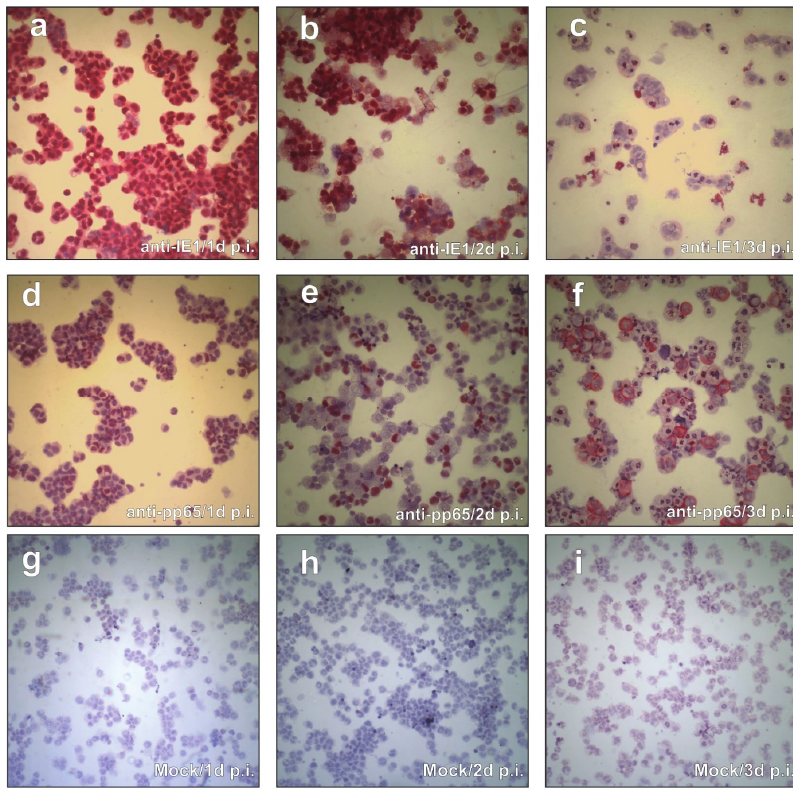
Figure 1. Viral protein expression in CAP sus. ( a – f ), cytospin preparations of HCMV infected CAP sus. , stained with mAbs against IE1 ( a – c ) and pp65 ( d – f ). Cells were infected with TowneUL130rep at an m.o.i. of 0.5. ( g – i ), mock-infected cells. Cytospin preparation and staining was performed at the indicated times after infection. Red color depicts specific staining of the viral